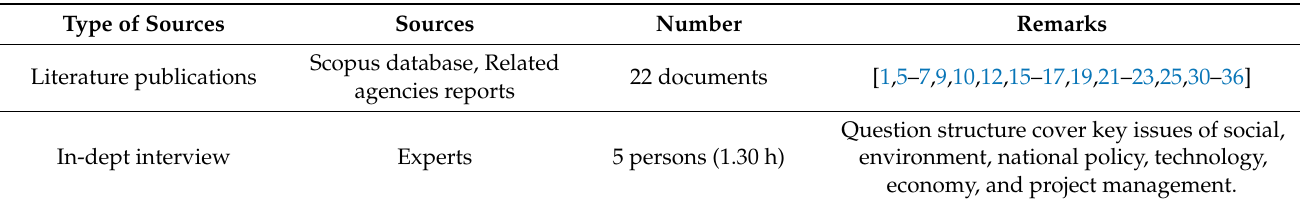
Table 1. Sources of barriers of this study.